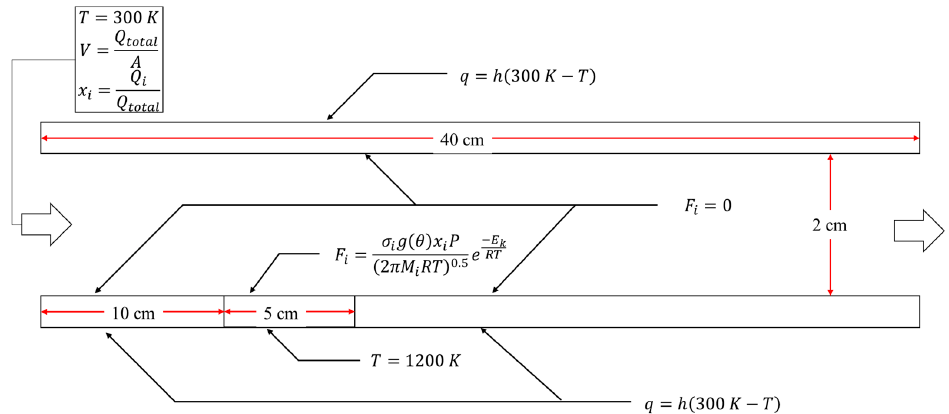
Figure 1. Schematic diagram and boundary conditions of a simplified horizontal MOCVD